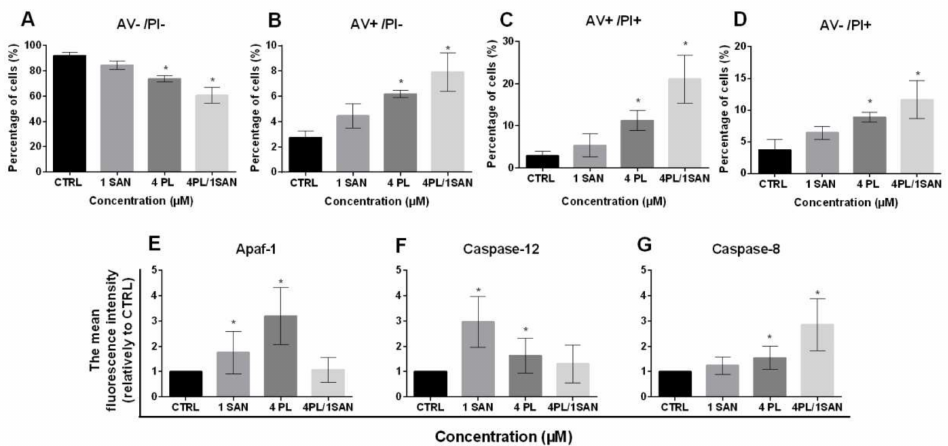
Figure 4. The e ff ect of piperlongumine (PL) and sanguinarine (SAN) individually and in a combined treatment on the cell death of A549 cells. Annexin V / propidium iodide (AV / PI) assay. ( A ) The percentage of live cells (AV − / PI − ). ( B ) The percentage of early-apoptotic cells (AV +/ PI − ). ( C ) The percentage of late-apoptotic cells (AV +/ PI + ). ( D ) The percentage of necrotic cells (AV − / PI + ). Data represent the mean values ± SD obtained from 6 independent replicates ( n = 6). The cytometric analysis of cell death-related proteins Apaf-1 ( E ), caspase-12 ( F ) and caspase-8 ( G ). Data represent the mean values ± SD obtained from 4 independent replicates ( n = 4) and presented as folds in relation to the control (CTRL) (estimated as 1). Statistically significant di ff erences in comparison to untreated cells were marked as * ( p < 0.05; Kruskal-Wallis with Dunn’s post hoc